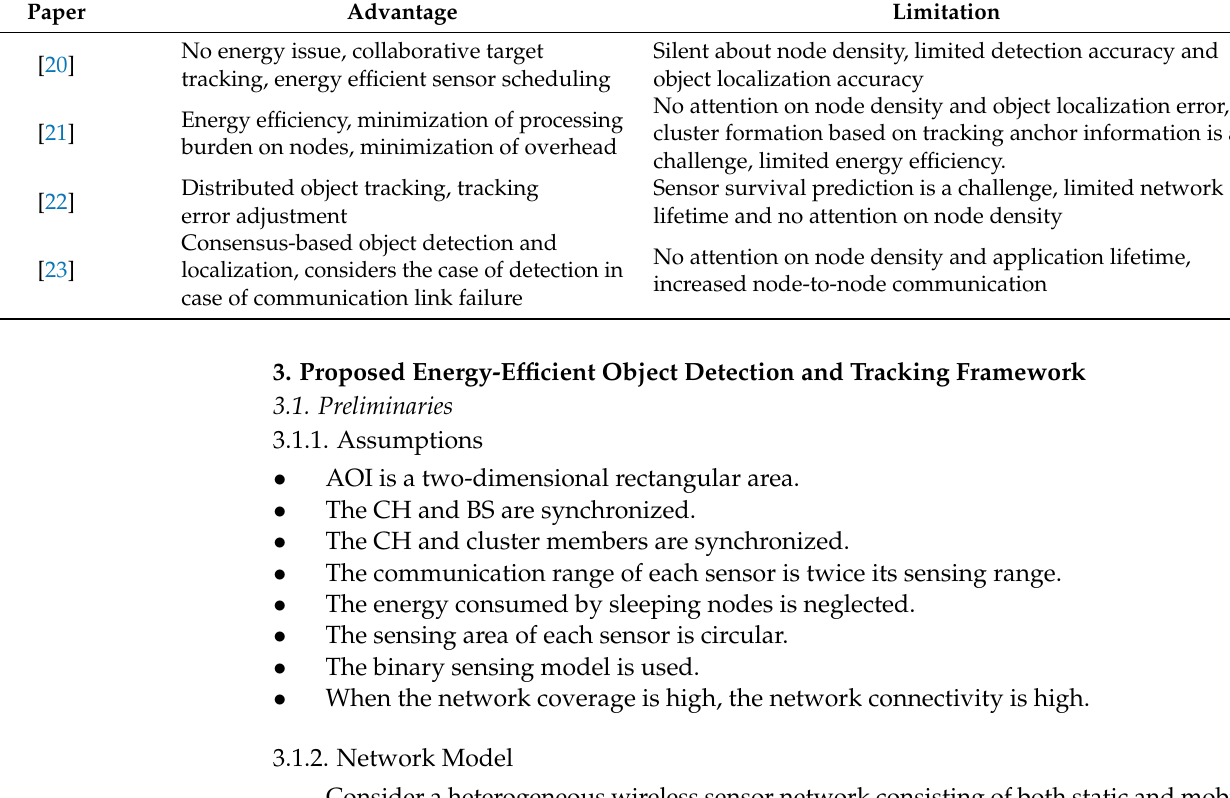
Figure 2. System architecture of EEODTF. If the signal strength is greater than the threshold, then the object is present. Other- wise, the object is absent. The sensor sends this information to the CH. The CH aggregates this information from the sensor nodes, and a final decision is made on the basis of the aggregated signal. The final decision is reported to the BS. Then, the BS initiates the pro- cess of object localization.